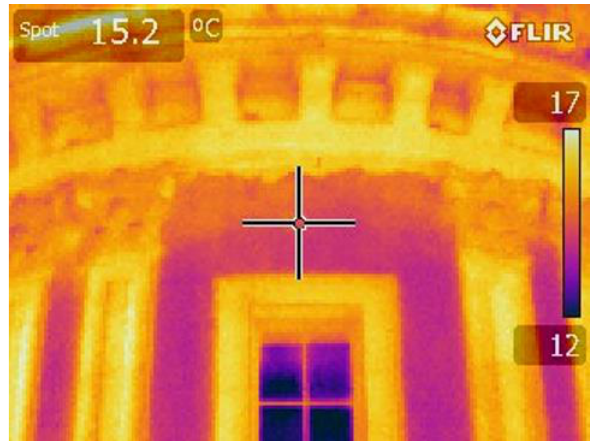
Figure 13. Santa Caterina a Formiello Church. Thermal photography of a span of the drum (R. Amore and M. Facchini, DiARC MLab, 2019).